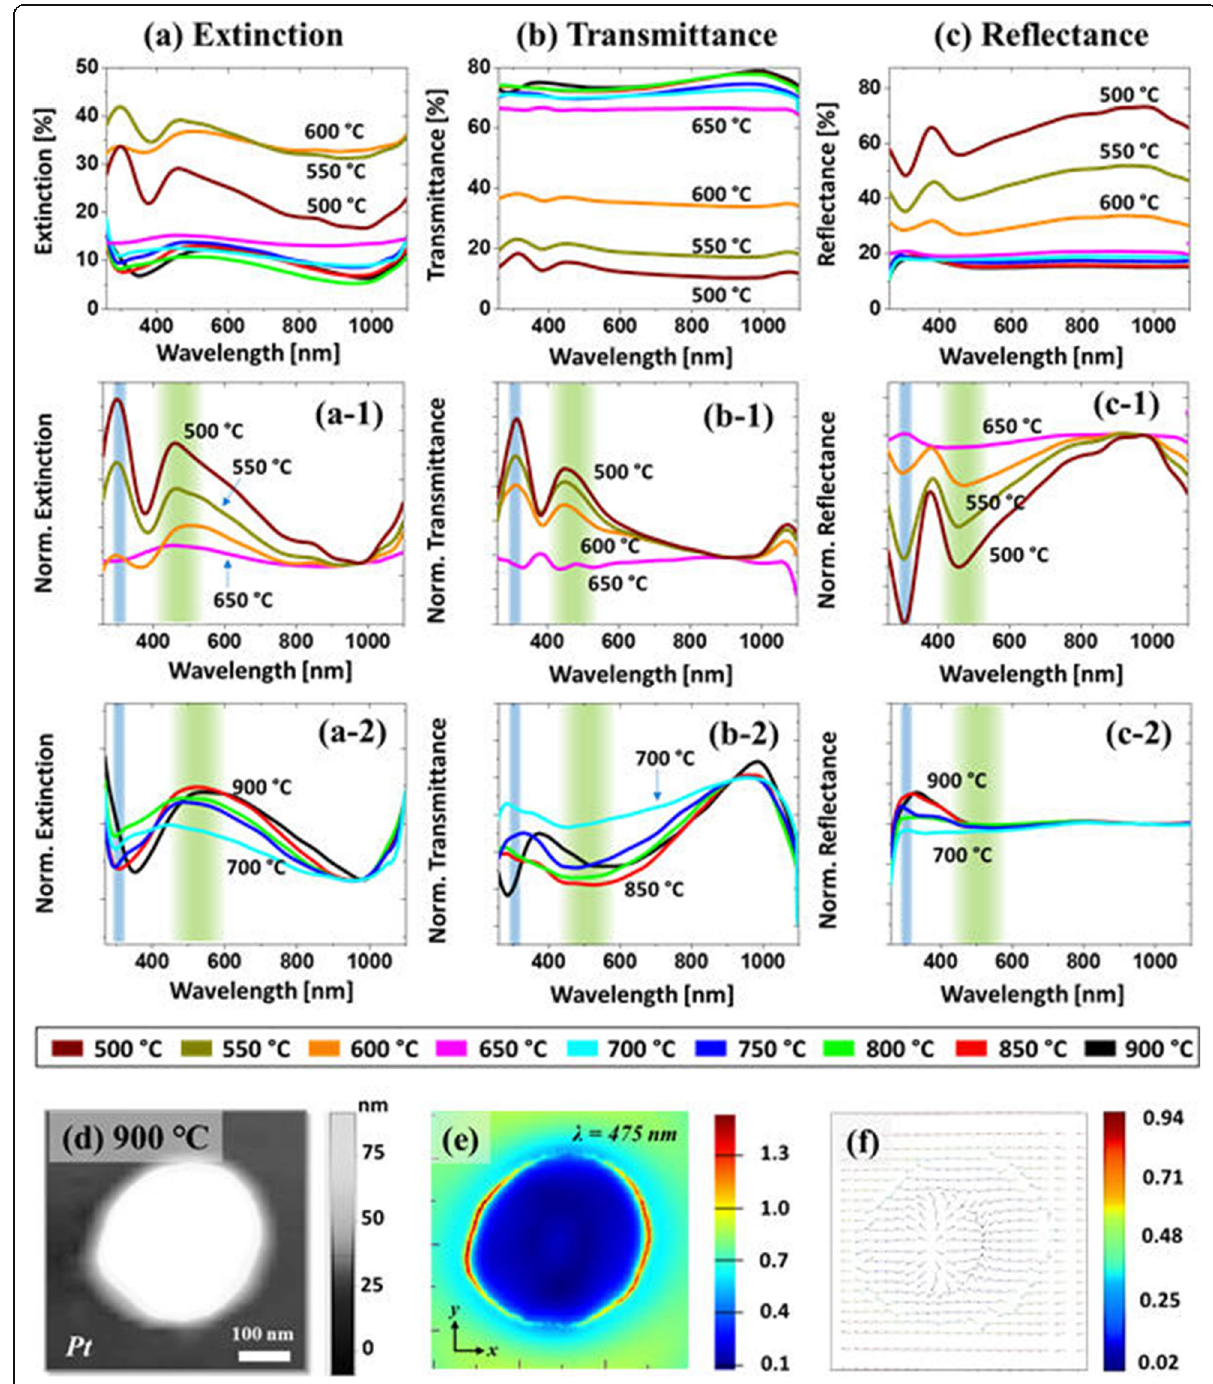
Fig. 7 LSPR properties of the AgPt nanoclusters and Pt NPs fabricated with the Ag21nm/Pt4.5 nm bilayer between 500 and 900 °C. a – ( a-2 ) Extinction and normalized extinction spectra. b – ( b-2 ) Transmittance and normalized transmittance spectra. c – ( c-2 ) Reflectance and normalized reflectance spectra. d AFM image of the Pt NP selected for the FDTD simulations. e E-field distribution. f Corresponding e-field vector